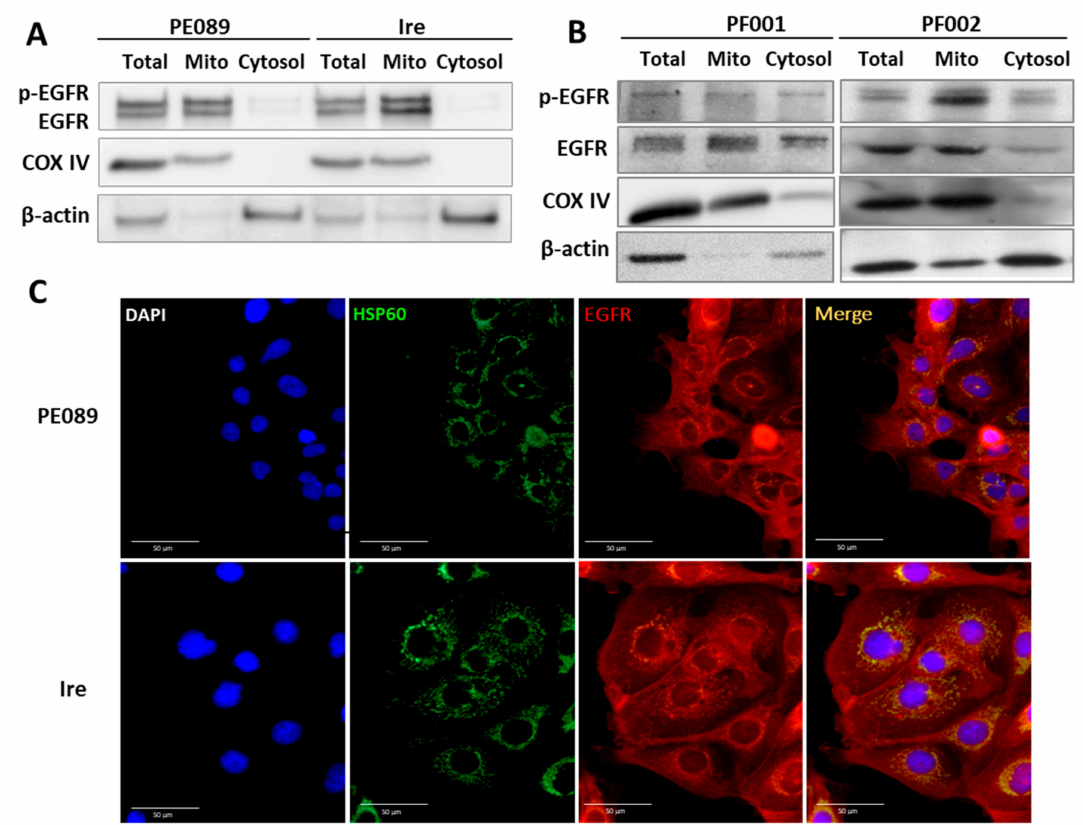
Figure 2. Mitochondrial translocation of EGFR was found in PE089 cells, Ire cells, and lung adenocarcinoma cells. ( A ) The mitochondrial fraction (Mito) and cytosolic fraction (Cytosol) of PE089 and Ire cells were isolated by di ff erential centrifugation. Representative immunoblottings of p-EGFR, EGFR, cytochrome c oxidase subunit IV (COX IV) and β -actin of PE089 and Ire cells are shown. COX IV was used as the mitochondrial marker protein. β -Actin was used as the cytosolic marker protein. Total protein lysate. ( B ) The mitochondrial fraction and cytosolic fraction of the patient-derived PF001 and PF002 cells were purified. PF001 and PF002 cells were collected from patients with EGFR-positive lung adenocarcinoma. ( C ) PE089 cells and Ire cells were immunodetected by anti-EGFR-CF594 (red signals) and anti-HSP60-CF488A (green signals). Nuclei were stained with DAPI (blue signals) (scale bars, 50 µ m). The increased mitochondrial mass and the mitochondria-localized EGFR are